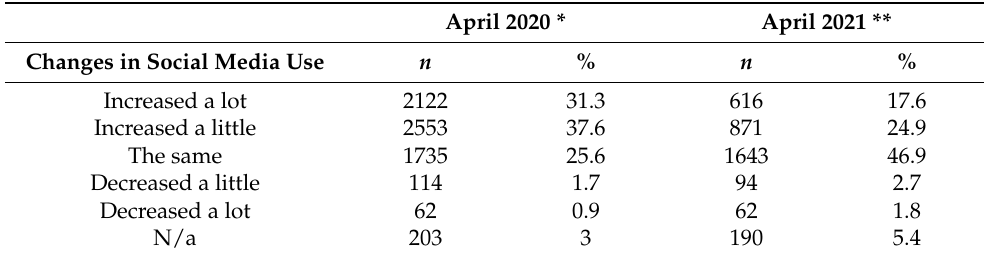
Table 4. Changes in social media use from April 2020 ( n = 6789) to April 2021 ( n =